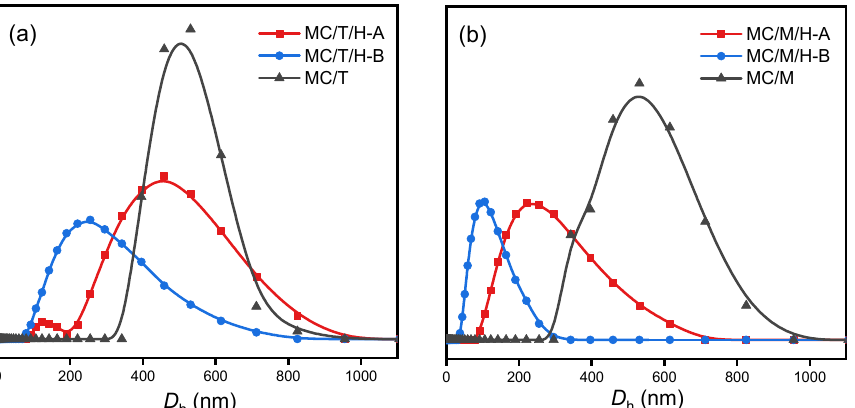
Figure 2. Hydrodynamic diameter distributions of multiple-crosslinked nanogels prepared with different methods. The concentrations of TPP ( a ) or Na 2 MoO 4 ( b ) were 0.05 mg mL − 1 , respectively.